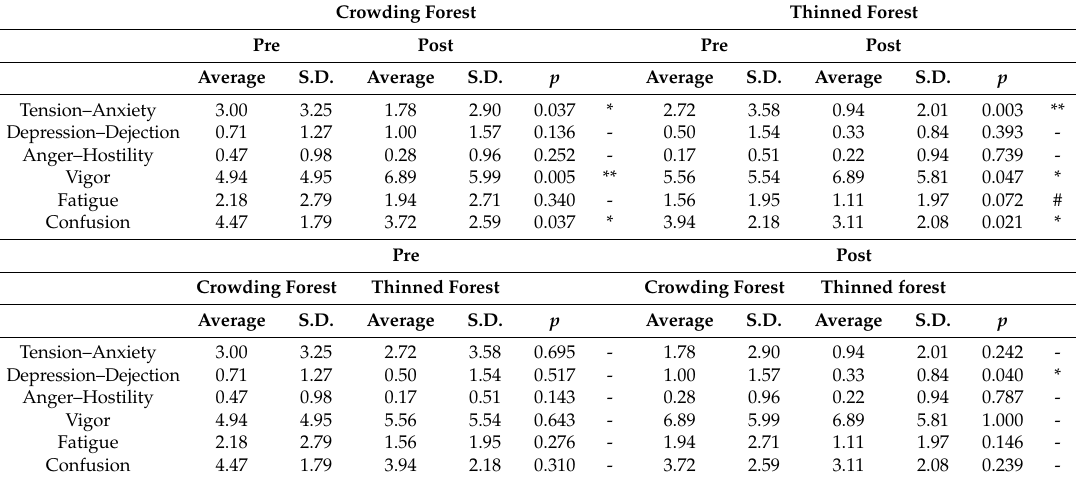
Table 8. Results of multiple comparisons of POMS scores for thinned versus crowding forests and for before and after forest